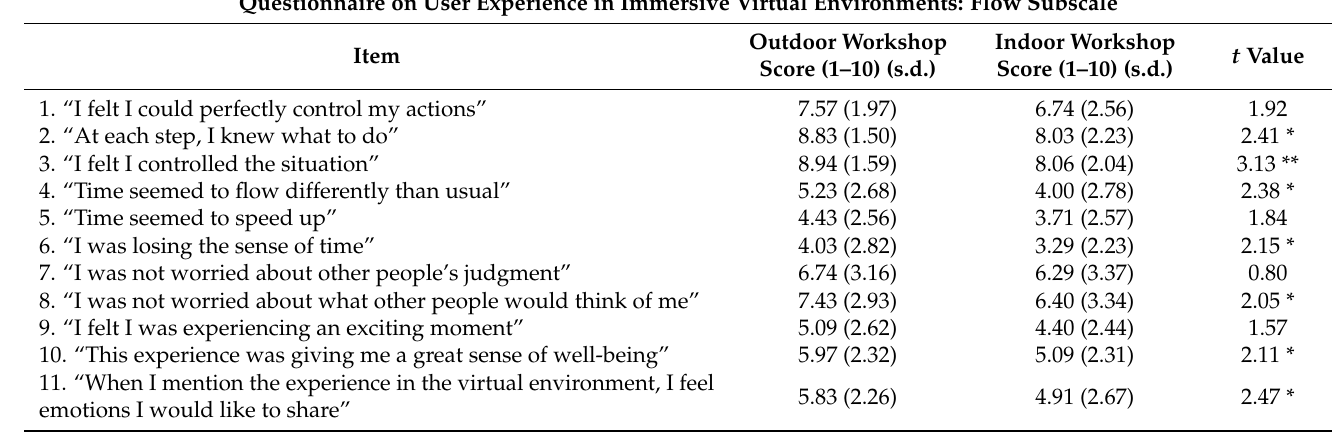
Table 6. Questionnaire on User eXperience in Immersive Virtual Environments: flow subscale. Questionnaire on User Experience in Immersive Virtual Environments: Flow Subscale